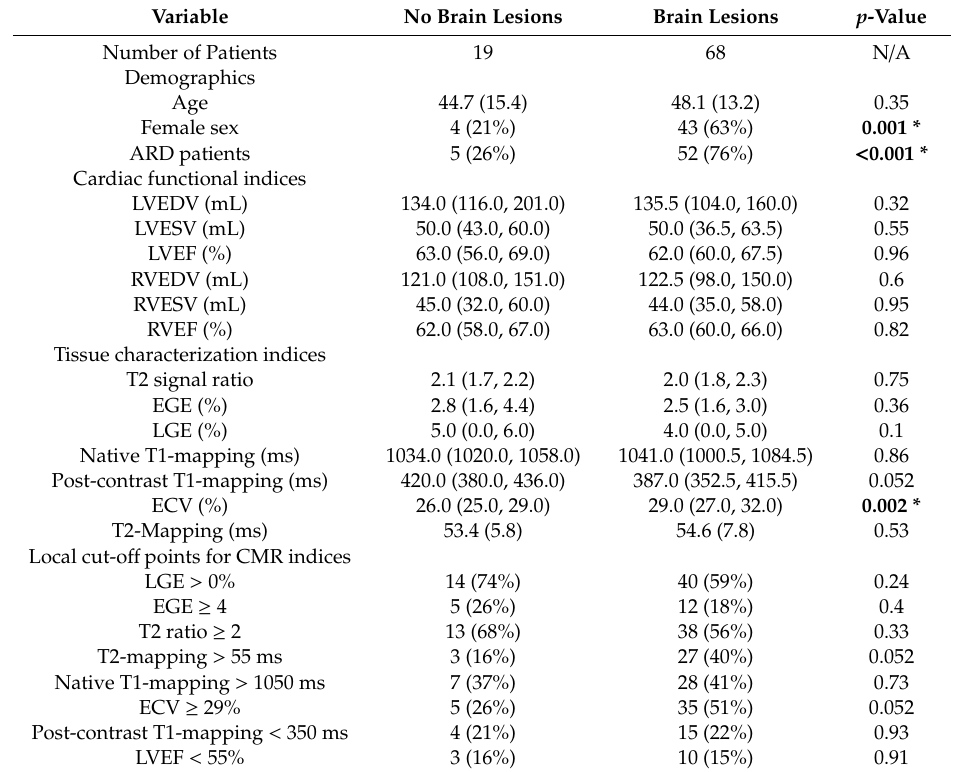
Table 2. Baseline characteristics compared between patients with and without identified brain lesions.